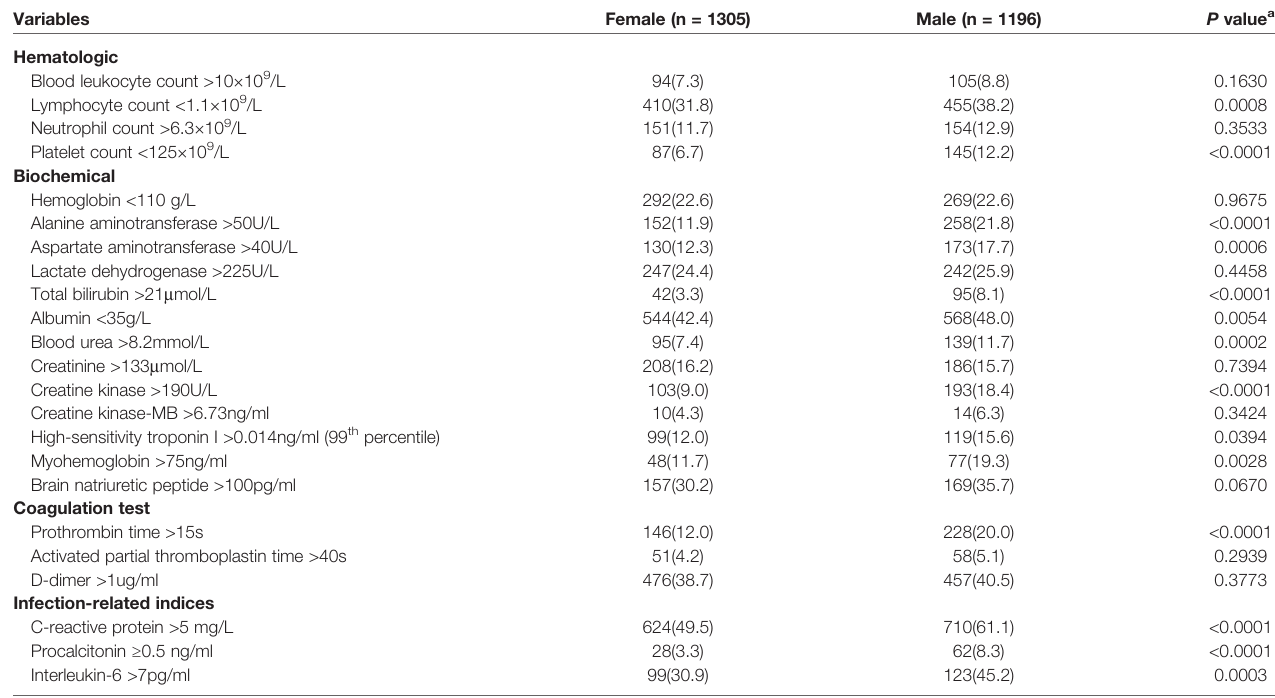
TABLE 2 | Laboratory fi ndings in female and male patients with COVID-19 on admission. Variables Hematologic Blood leukocyte count >10×10 9 /L